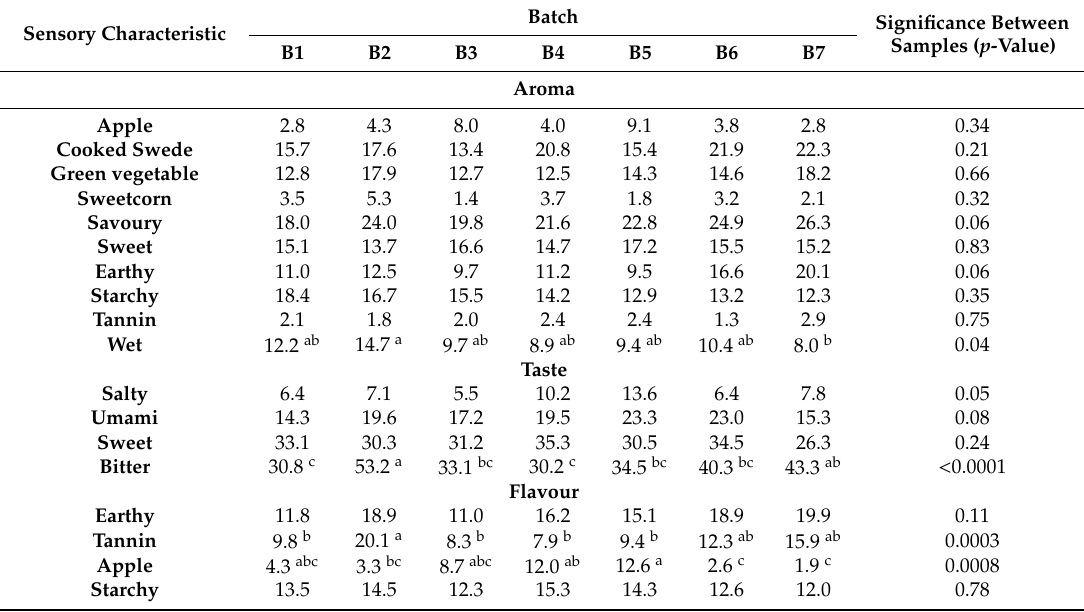
Table 4. Mean scores for sensory characteristics for seven batches of steamed-pureed turnip. Di ff erent superscript letters indicate significant di ff erences between